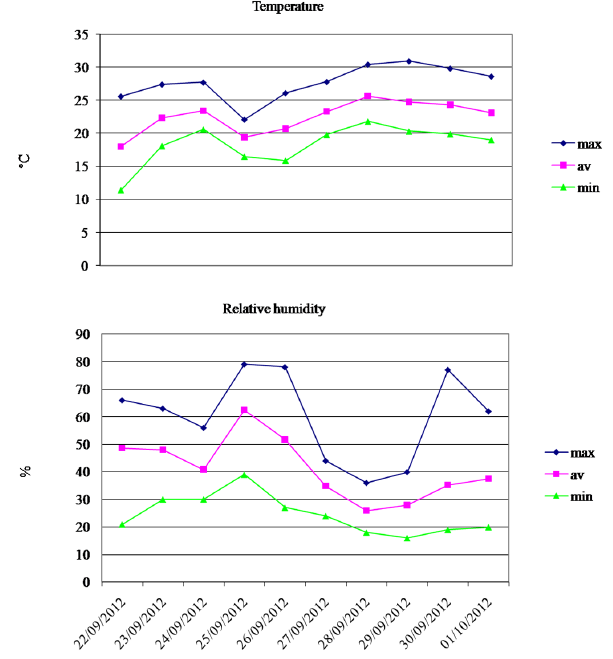
Figure 2. Temperature and relative humidity trends during the ob- servation period at the Viggiano Civil Protection weather station.